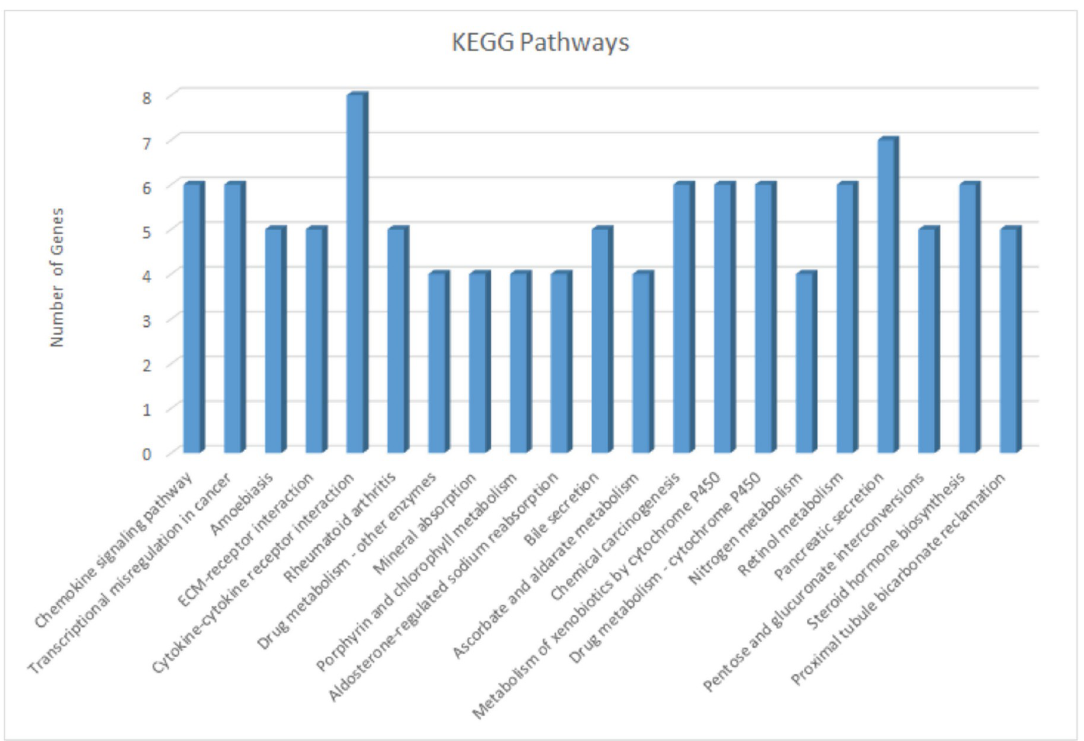
Fig 20. KEGG pathways of involved validated Differentially Expressed Genes (vDEGs).